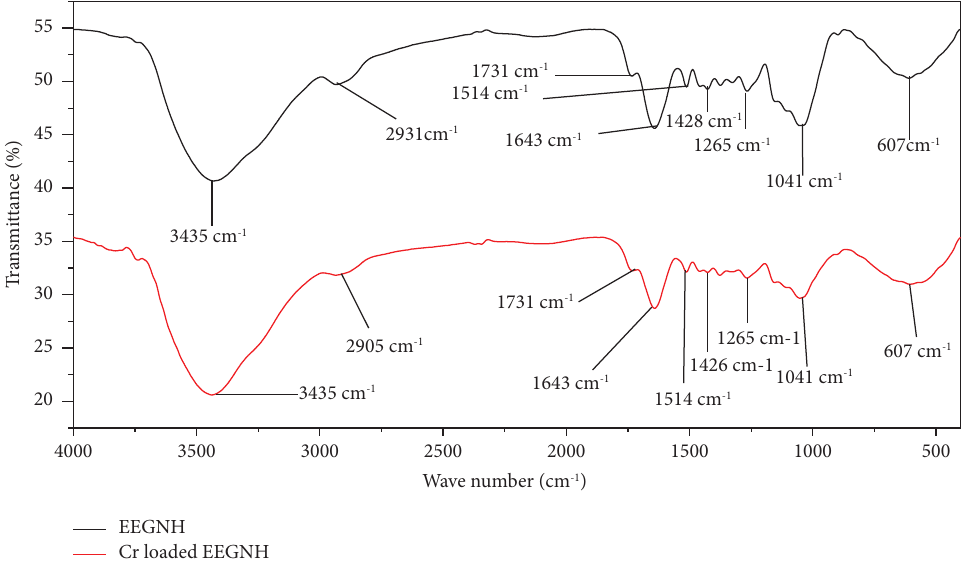
Figure 3: FTIR analysis of ethanol-extracted groundnut husk (EEGNH) before and after Cr loaded.